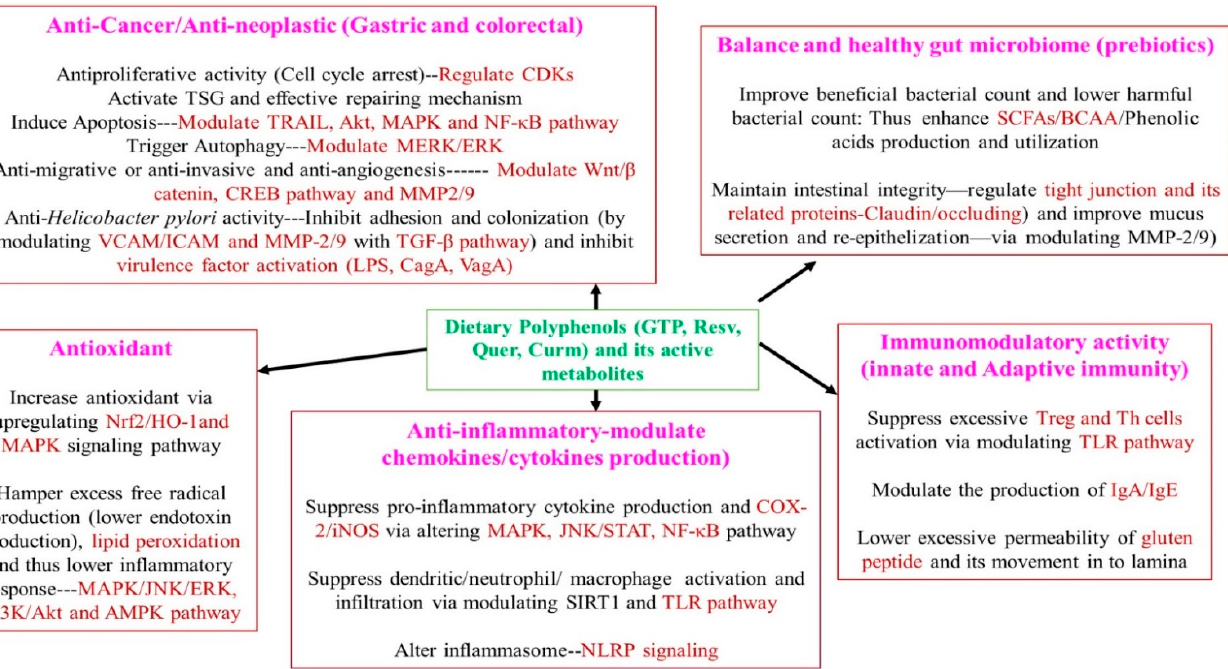
Figure 4. Brief description of the underlying gastroprotective mechanism of dietary polyphenols. GTP—green tea polyphenol, Curm—Curcumin, Resv—Resveratrol, Quer—Quercetin, Nrf2—Nuclear factor-E2-related factor, HO-1—Heme Oxygenase-1, NF- κ B—Nuclear factor Kappa B, SIRT—Sirtuin, MAPK—Mitogen-activated protein kinase, JNK—c-Jun N-terminal Kinase, PI3K/Akt—Phosphatidylinositol-3-kinase/Protein kinase B, ERK—extracellular signal-regulated kinase, JNK—c-Jun N-terminal kinase, STAT—signal transducers and activators of transcription, JAK—Janus kinase, AMPK—Adenosine monophosphate-activated protein kinase, TLR—Toll-like receptor, NLRP—Nod-like receptor protein, CREB—cAMP response element-binding, Wnt—Wingless-related integration site, CDKs—Cyclin-dependent kinases, MMP—Matrix metalloproteinase, VCAM—Vascular cell adhesion molecule, ICAM—Intracellular adhesion molecule, BCAA—Branched- chain amino acids, SCFAs—Short-chain fatty acids, Treg—Regulatory T cells, Th—Helper T cells.